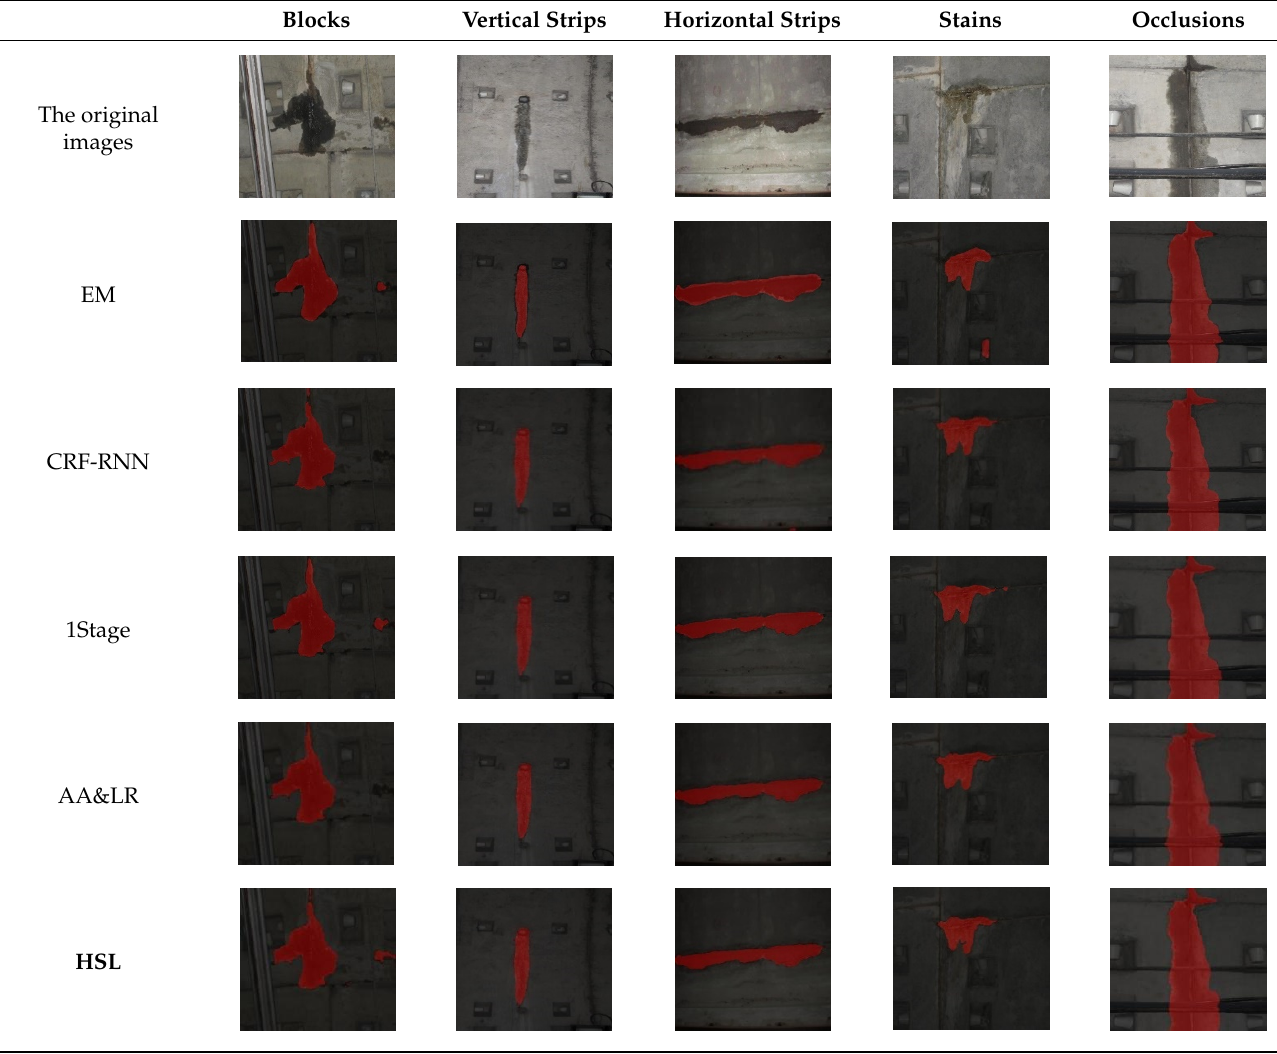
Table 9. MIoU and the efficiency comparison between the HSL and the end-to-end semantic seg- mentation network on the proposed dataset.